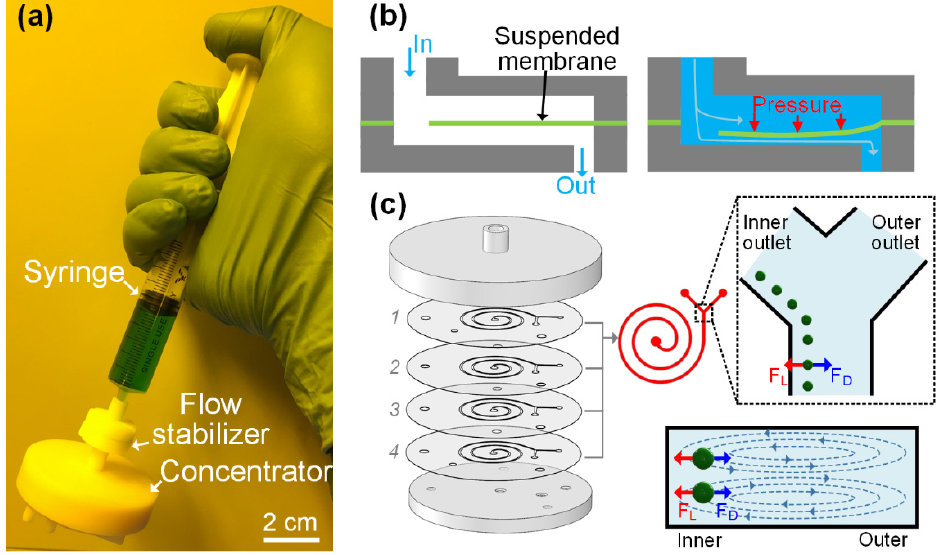
Figure 1. ( a ) Photograph illustrating the operation of the hand-operated syringe-tip inertial microfluidic centrifuge (i-centrifuge) for continuous-flow cell concentration. The i-centrifuge consists of a syringe-tip flow stabilizer and a syringe filter-like inertial microfluidic concentrator and can be quickly mounted onto the syringe tip via a simple press-fit connection. ( b ) Working principle of the flow stabilizer for regulating varied input liquid flow to be at a desired stable flow rate. ( c ) Structure and working principle of the syringe filter-like inertial microfluidic concentrator. Four spiral inertial microfluidic channels were integrated for achieving ultra-high throughout processing. The right part showed the cell inertial focusing principle at the position before the Y-shaped outlet system and in the cross-section of each spiral channel.